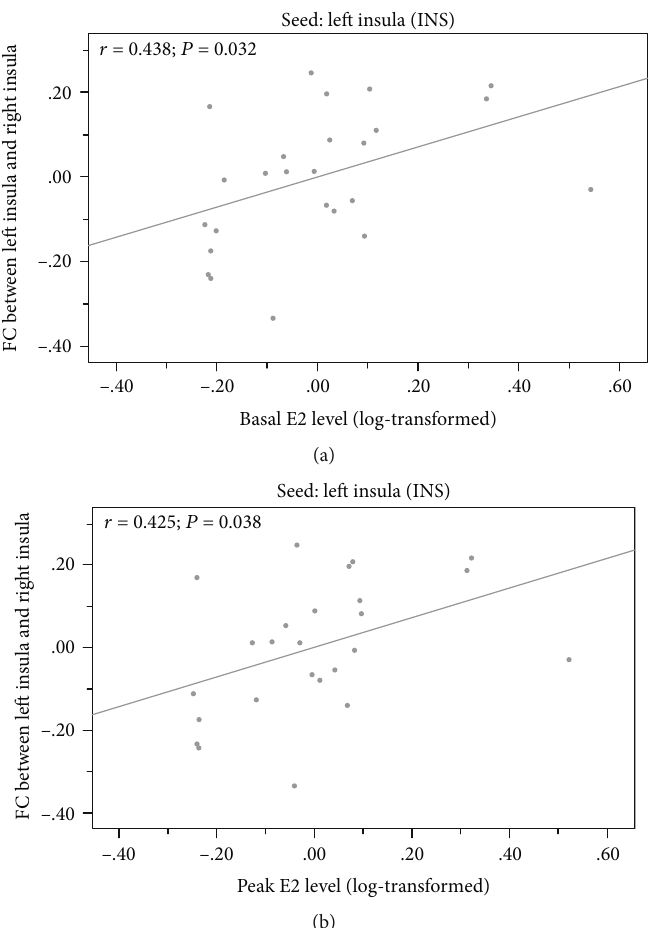
Figure 3: Correlation analysis between FC values and E2 level in the CPP group, stronger FC within the bilateral insula is associated with increased (a) basal and (b) peak E2 level (basal: r = 0 : 438 , P = 0 : 032 ; peak: r = 0 : 425 , P = 0 : 038